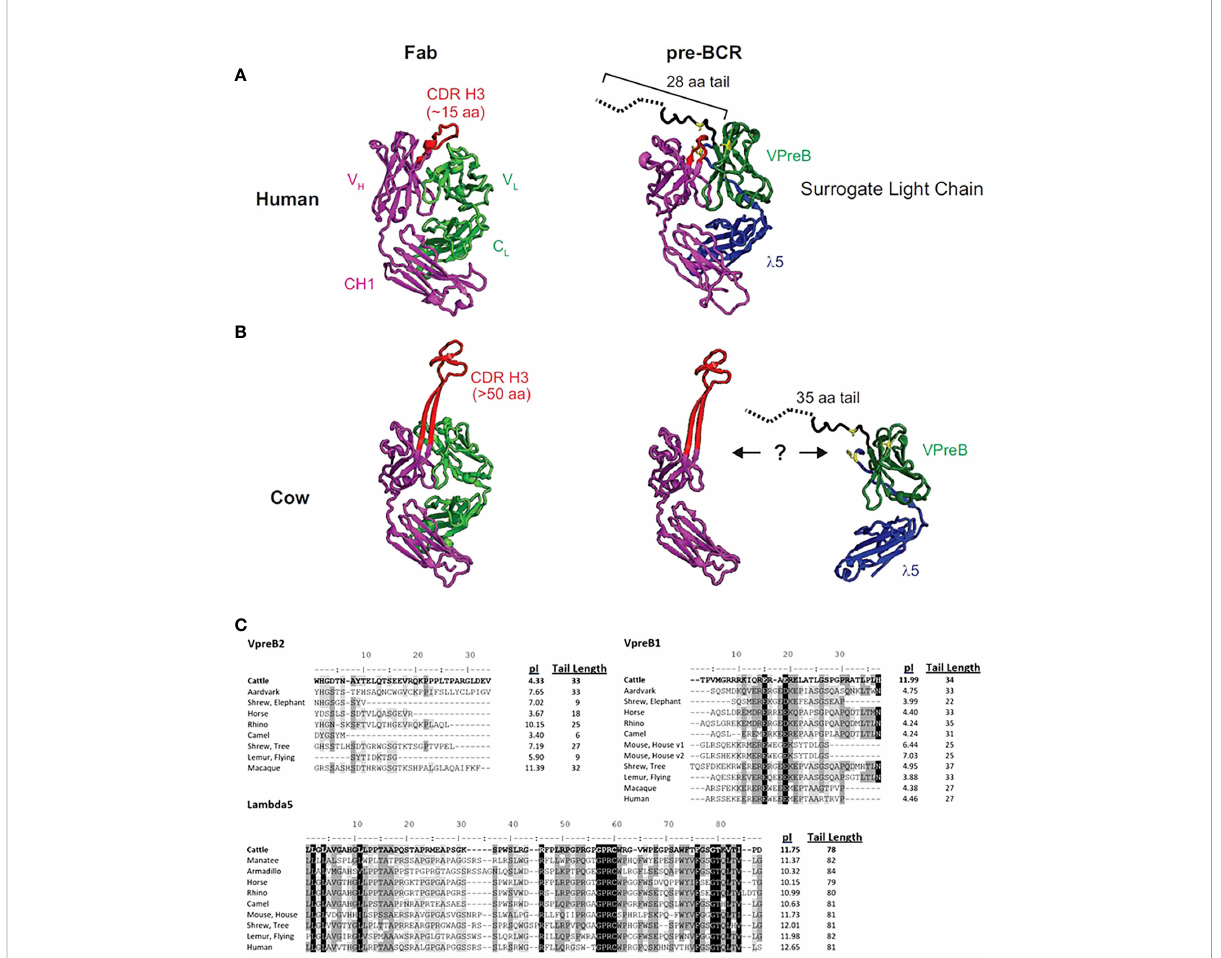
FIGURE 1 The human SLC may not accommodate an ultralong CDR H3. (A) A human fragment antigen-binding region (F ab ; PDB 5ZMJ; doi: 10.2210/ pdb5ZMJ/pdb) is shown next to a human pre-BCR composed of an immunoglobulin heavy chain (HC) paired with the surrogate light chain (SLC; PDB 2H3N; doi: 10.2210/pdb2H3N/pdb). (B) For comparison, a cow ultralong F ab (PDB 5IJV; doi: 10.2210/pdb5IJV/pdb) is shown next to ultralong HC of that Fab with the human SLC from (A) . The structures are colored as follows: purple = HC, red = CDR H3, light green = light chain, dark green = VpreB1, blue = l 5, yellow = SLC residues that are important for interacting with the HC, dotted black line = part of VpreB1 tail that was truncated to obtain the crystal structure. Note that the VpreB1 tail may not engage the apex of the CDR H3 knob. (C) Amino acid alignment of VpreB1 (top), VpreB2 (middle), and IGLL1 tail regions, isoelectric point (pI), and amino acid tail length from eutherian mammal species. Though mice have two variants (v1 and v2) of VpreB1, neither mouse nor human have VpreB2. Note the high pI (more basic) tail of cattle VpreB1 and low pI (more acidic) tail of cattle VpreB2 compared to other species. Residues are shaded based on similarity using a Blosum62 scoring matrix (threshold = 1, gaps ignored; highlights indicate similarity: black = 100% similar; dark gray = 80 – 100% similar; light gray = 60 – 80% similar; white = <60%